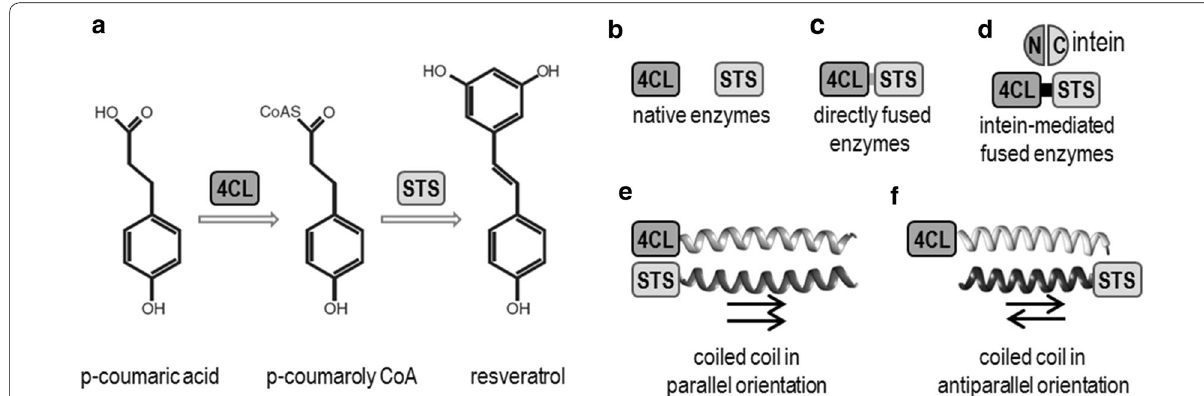
Fig. 1 Schematic illustration of resveratrol biosynthesis and different strategies for the protein-based clustering of metabolic enzymes. a The enzymes 4-coumarate CoA ligase (4CL) and stilbene synthases (STS) are involved in resveratrol production from p-coumaric acid. b Native enzymes were used as a reference for resveratrol quantification. c, d Two strategies were based on the covalent fusion of the enzymes 4CL and STS: direct genetically encoded fusion ( c ) and intein-mediated fusion ( d ). e, f The interactions of designed coiled-coil-forming domains bring both enzymes into proximity. Coiled-coil dimers can have either a parallel ( e ) or an antiparallel ( f )